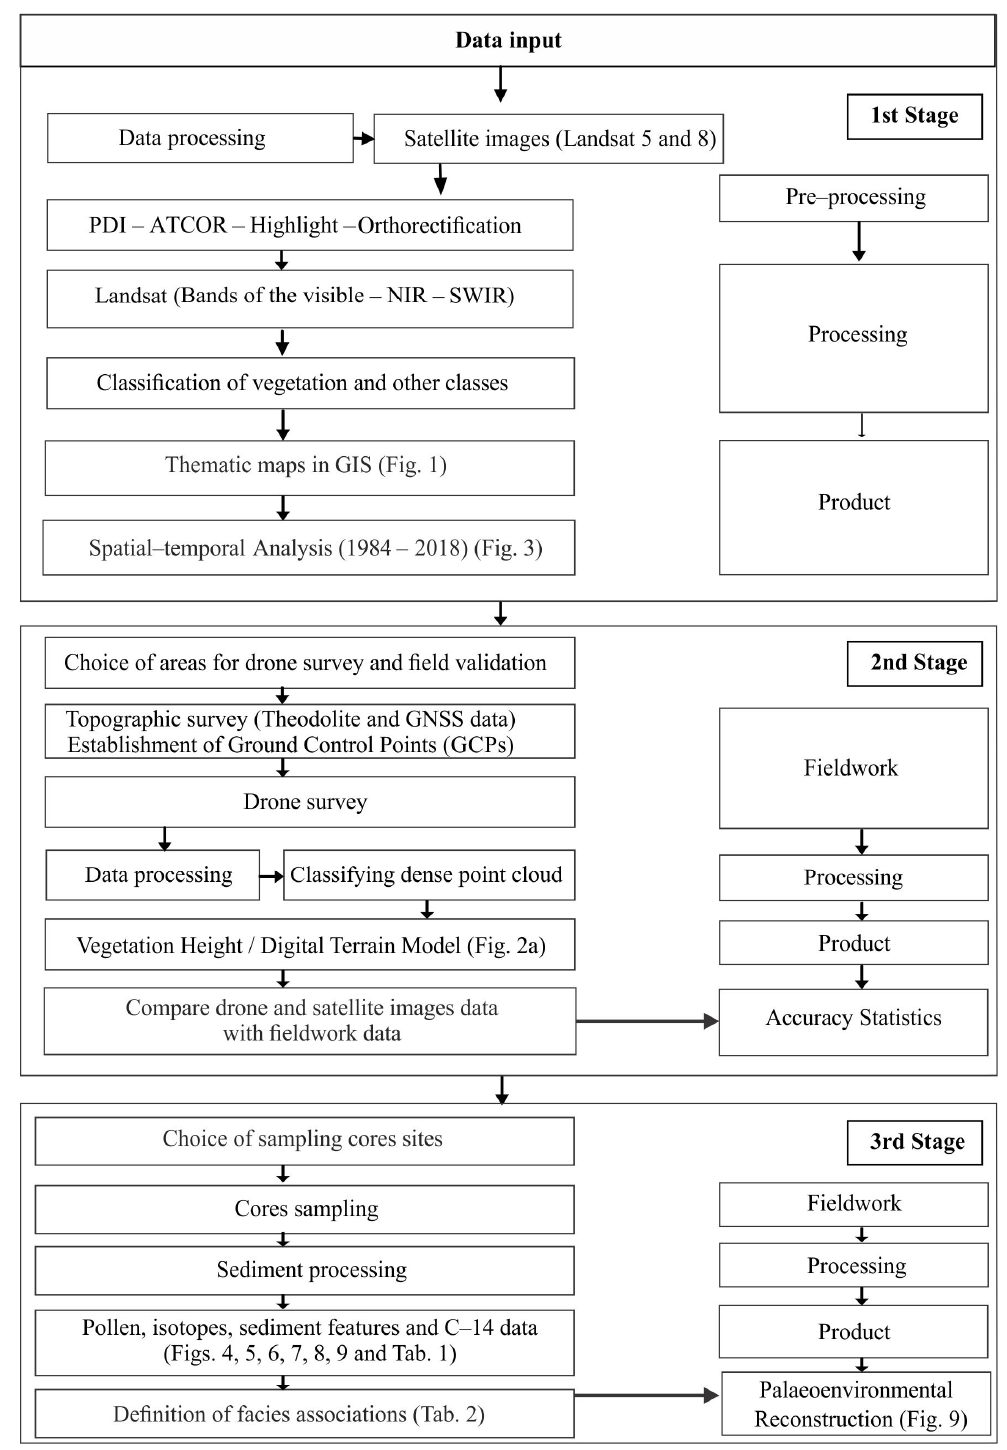
Figure 10. Methodology flow chart. Figures 1, 2a, 3–9 and Tables 1 and 2 are cited in this figure.